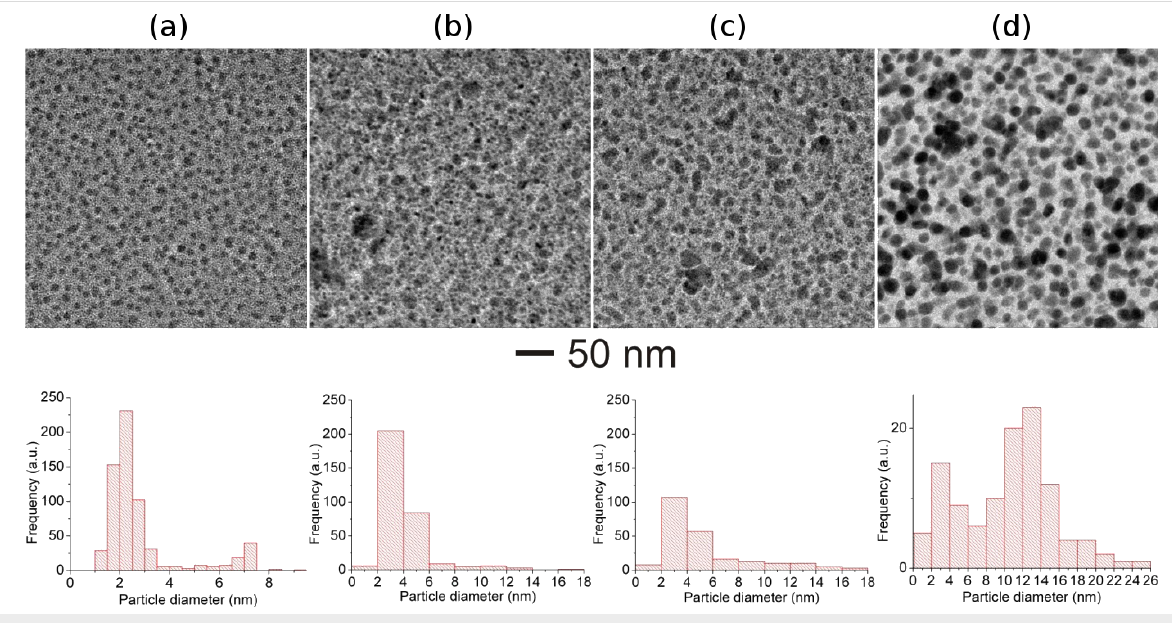
Figure 4: Morphological evolutions in Ag–TiO 2 nanocomposite films (MVF ≈ 15%) under 100 MeV Ag 8+ ion irradiation at different fluences. Bright- field TEM image of: (a) pristine film, (b) 1 × 10 12 ions/cm 2 , (c) 3 × 10 12 ions/cm 2 , (d) 1 × 10 13 ions/cm 2 . The particle size distributions corresponding to each TEM image are shown below the